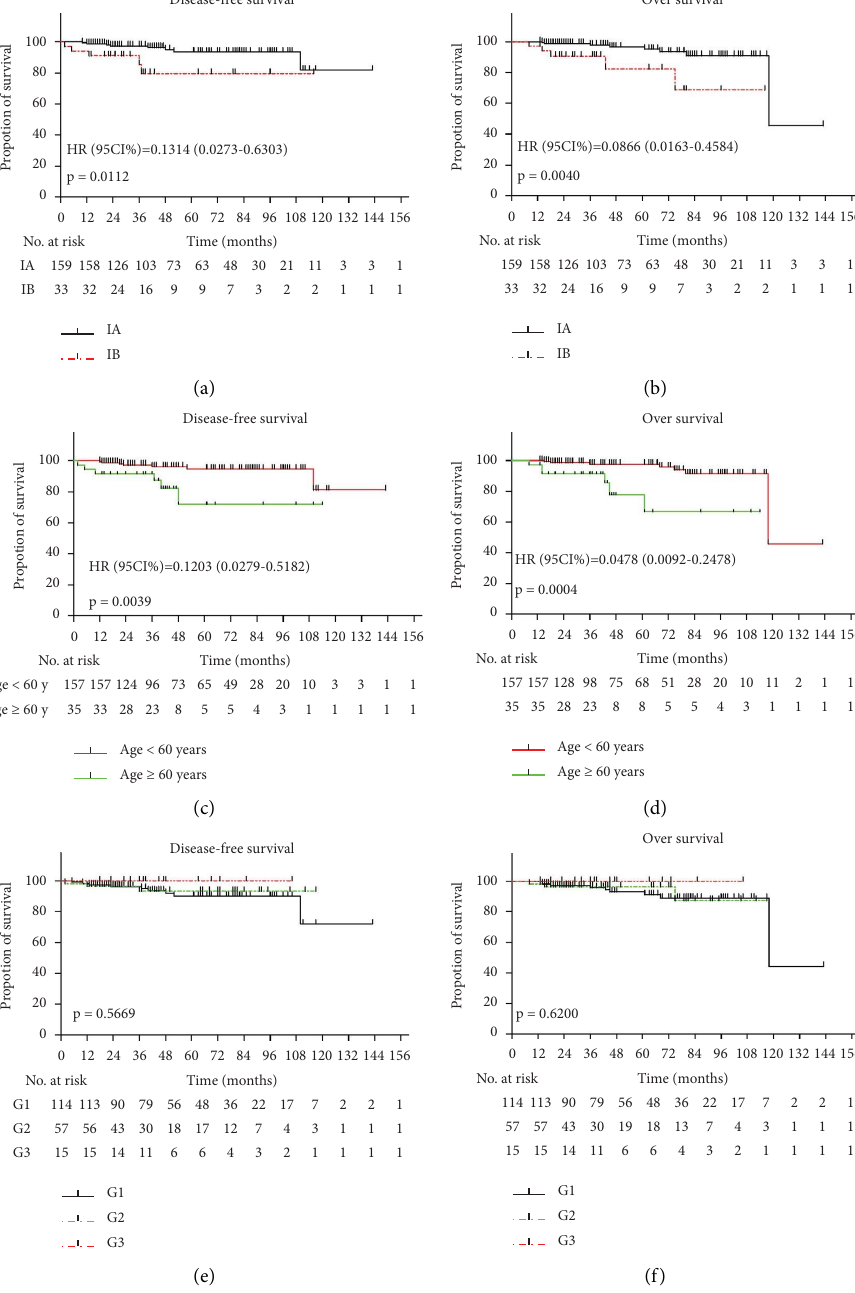
Figure 4: Disease-free survival and overall survival of all patients by FIGO stage, age and histologic grade. Kaplan-Meier survival curves for disease-free survival and overall survival by FIGO stage in all patients who received with diferent adjuvant treatments compared with patients who received no adjuvant treatment. Tick marks indicate censored data [(a), HR (95% CI): 0.1314 (0.0273–0.6303), P � 0 . 0112; and (b) HR (95% CI): 0.0866 (0.0163–0.4584), P � 0 . 0040]. DFS (c) and OS (d) by age [(c), HR (95% CI): 0.1203 (0.0279–0.5182), P � 0 . 0040; and (d) HR (95% CI): 0.0478 (0.0092–0.2478), P � 0 . 0004]. Panels (e) and (f) show the DFS and OS, respectively, according to diferent degrees of diferentiation (e) P � 0 . 5669; and (f) P � 0 .